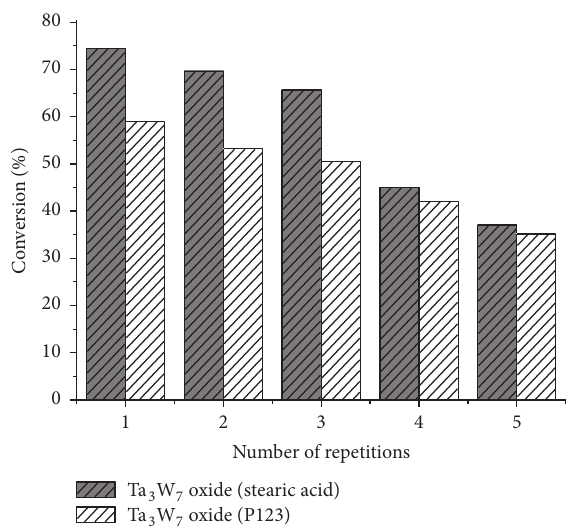
Figure 13: The reusability of mesoporous Ta 3 W 7 oxide (stearic acid and